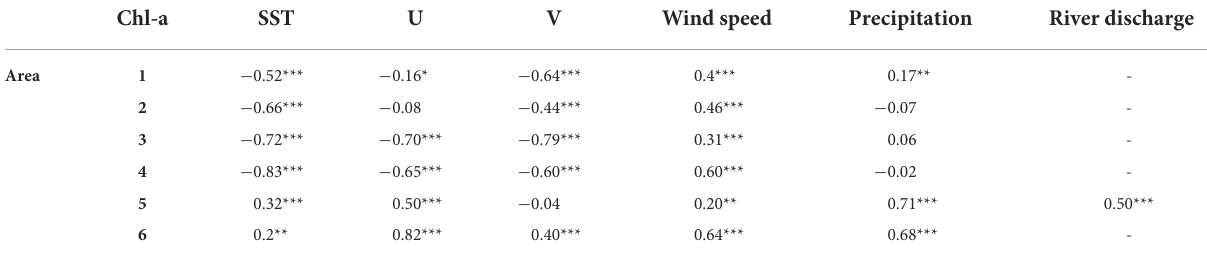
TABLE 1 Correlation coefficients between chl-a and environmental parameters. Chl-a SST U V Wind speed Precipitation River discharge